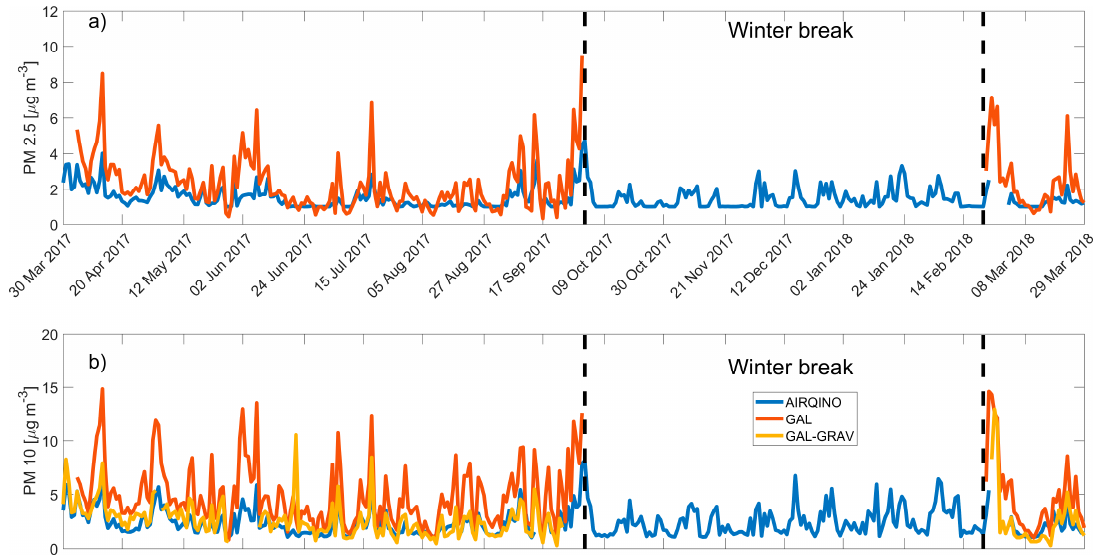
Figure 5. Time trends of PM 2.5 ( a ) and PM 10 ( b ) for AIRQino sensor (blue), GAL (orange line), and GAL-GRAV (yellow line). Dashed black lines delimitate the winter period of inactivity of the GAL.